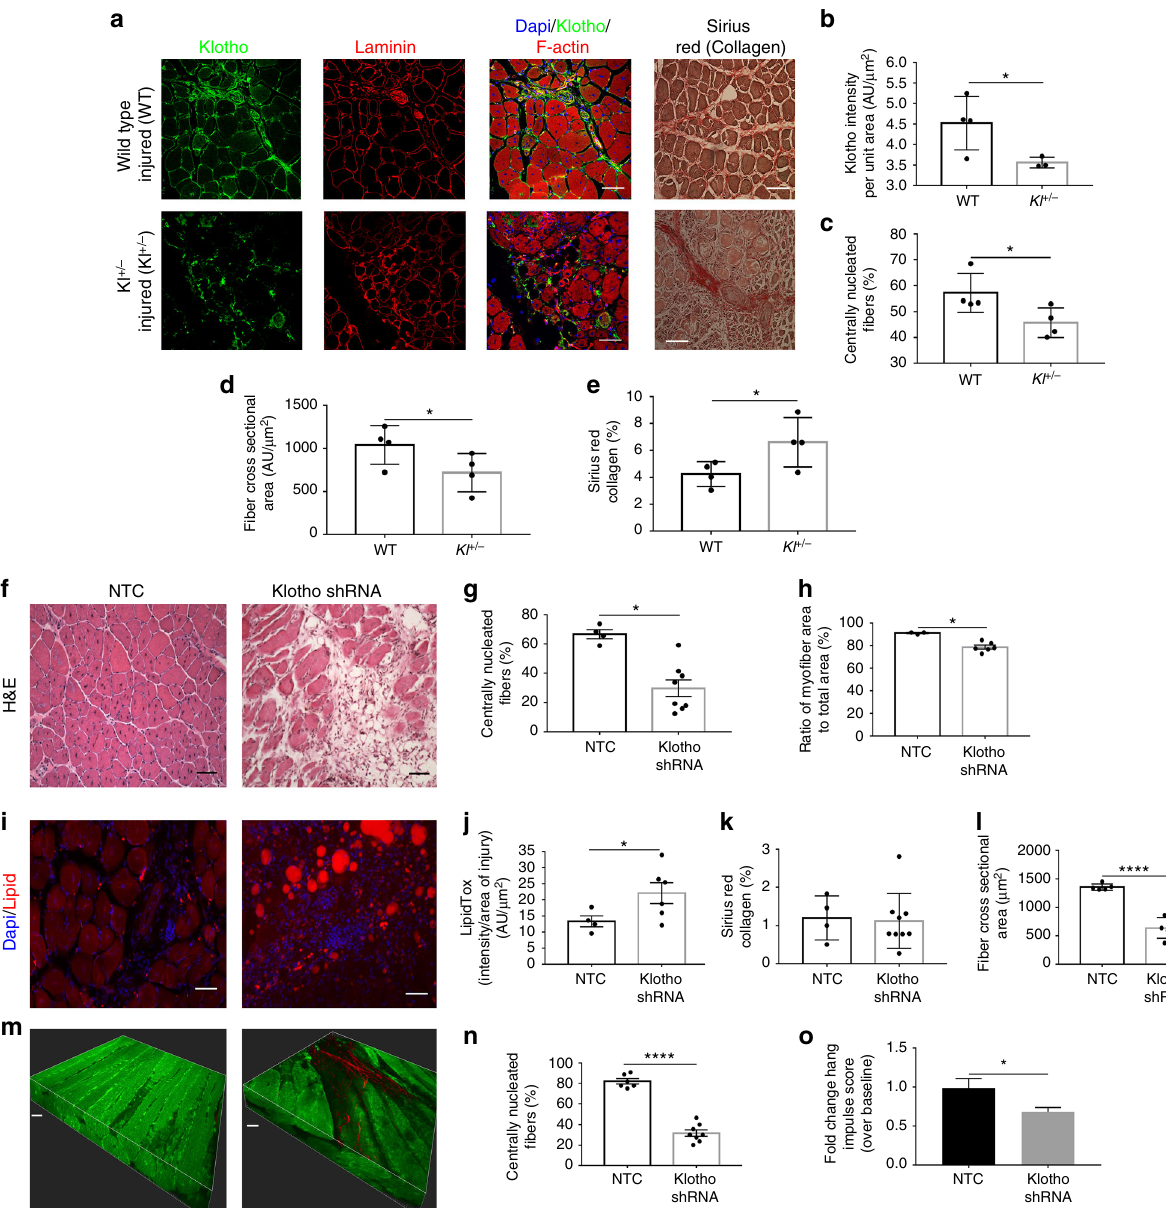
Fig. 2 Genetic and muscle-speci fi c loss of α -Klotho impairs skeletal muscle regeneration. a Immuno fl uorescence of α -Klotho, laminin, F-actin, and Sirius red stain in wild-type and Kl + / − mice 14 dpi. Scale: 50 µ m. b Quantitation of α -Klotho in wild-type versus Kl + / − mice 14 dpi ( n = 3 – 4/group; * p < 0.05,